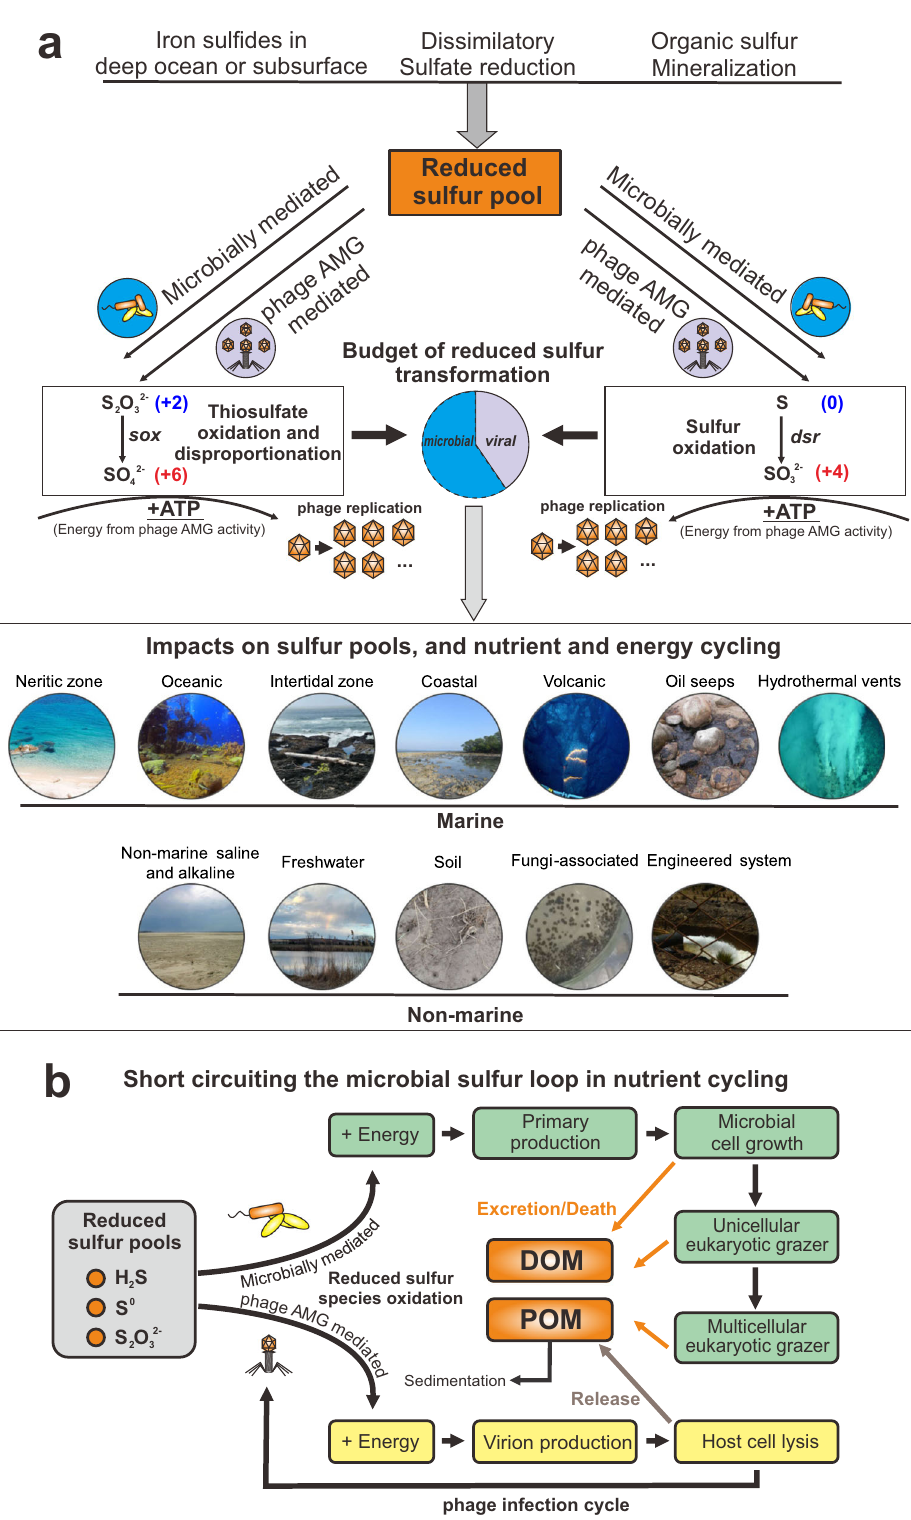
Fig. 8 Conceptual fi gure indicating the ecology and function of AMGs in sulfur metabolisms. a DSM AMG effect on the budget of reduced sulfur transformation. b Diagram of virus-mediated metabolism short circuiting the microbial sulfur loop in nutrient cycling. DOM: dissolved organic matter, POM: particulate organic